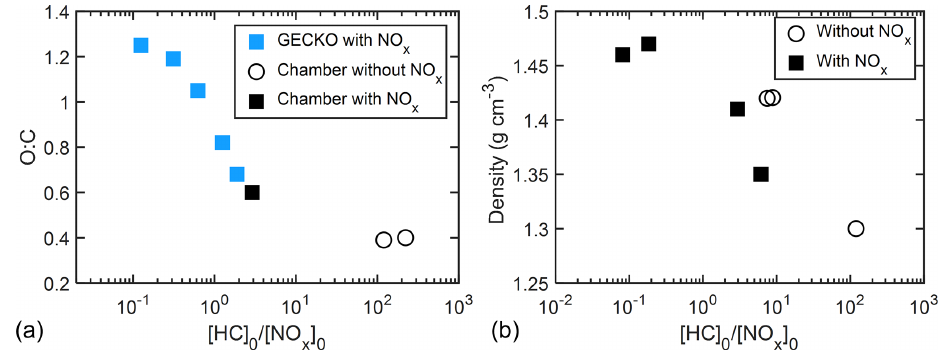
Figure 11. (a) O:C ratio as a function of [HC] 0 / [NO x ] 0 with AMS data and prediction by GECKO-A simulation. (b) Particle density (directly measured by APM–SMPS) shown as a function of [HC] 0 / [NO x ] 0 .